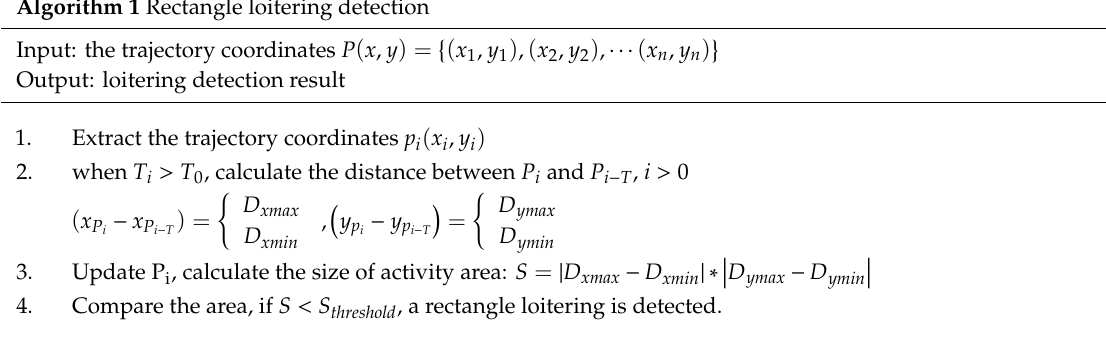
Algorithm 1 Rectangle loitering